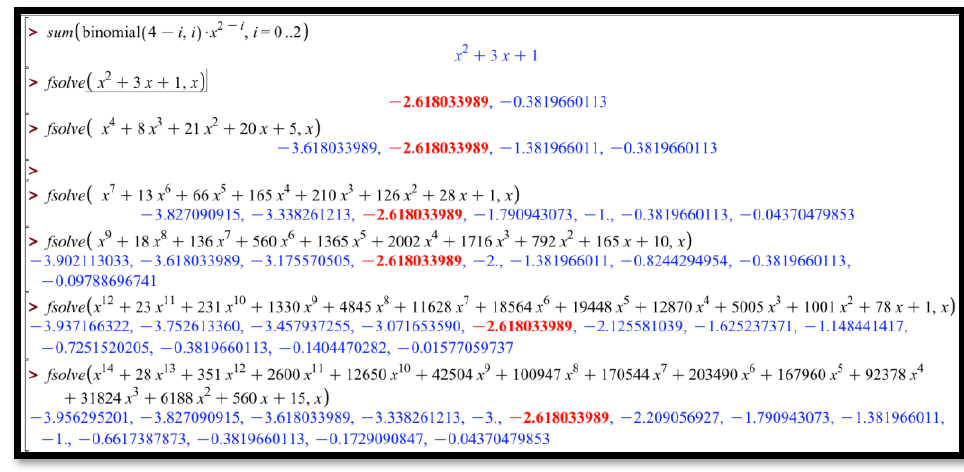
Figure 9. Exploring OAs among the roots of 𝑃 3𝑛+1 (𝑥) for x = − 1.